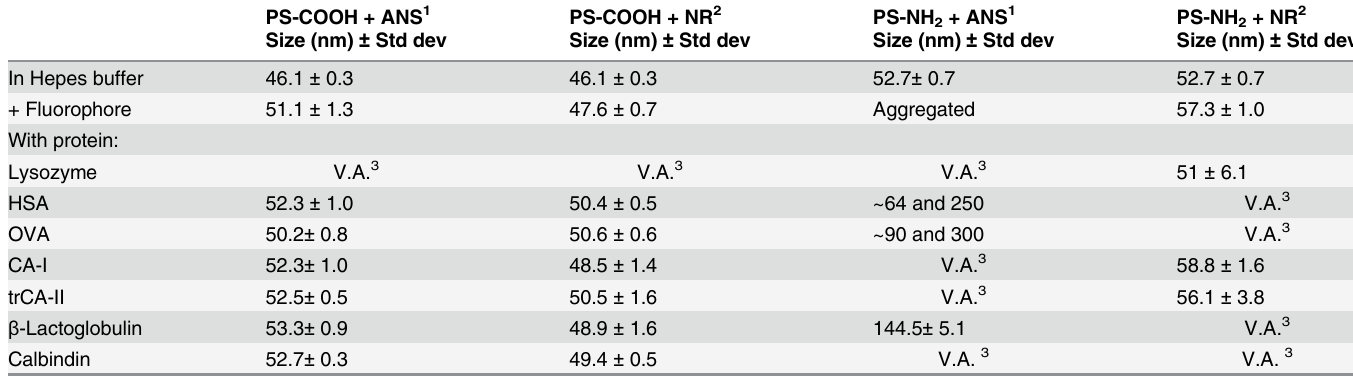
Table 1. NP sizes before and after screening